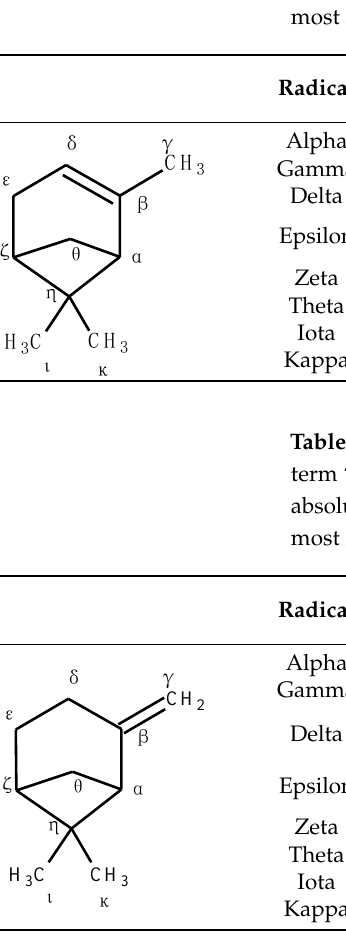
Figure 2. DFT/LAN level-optimized transition state structures for the hydrogen transfer to CYP through the cis reaction path in the doublet state for the R and S α -pinene